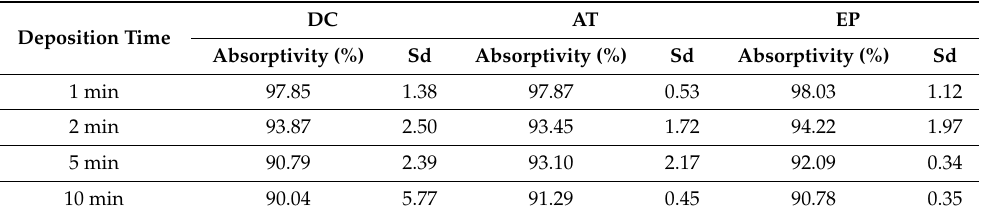
Table 4. Coatings absorptivity according to the treatments performed and deposition times (DC-Detergent cleaning, AT-Acid treatment,